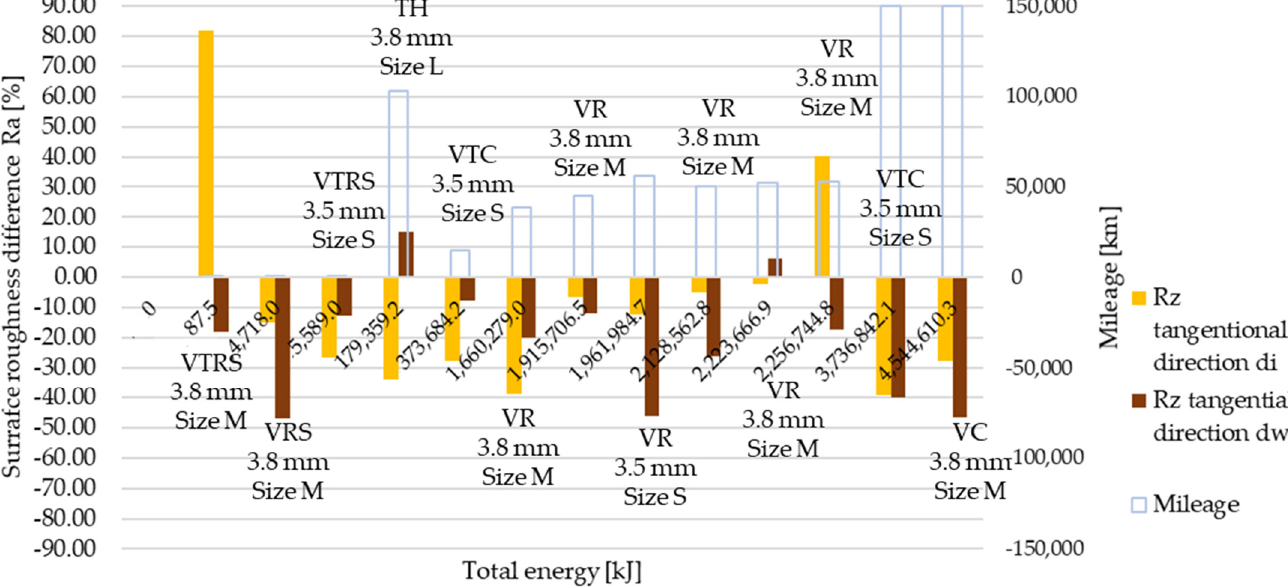
Figure 15. Deviation of Rz surface roughness values from initial conditions, tangential direction.